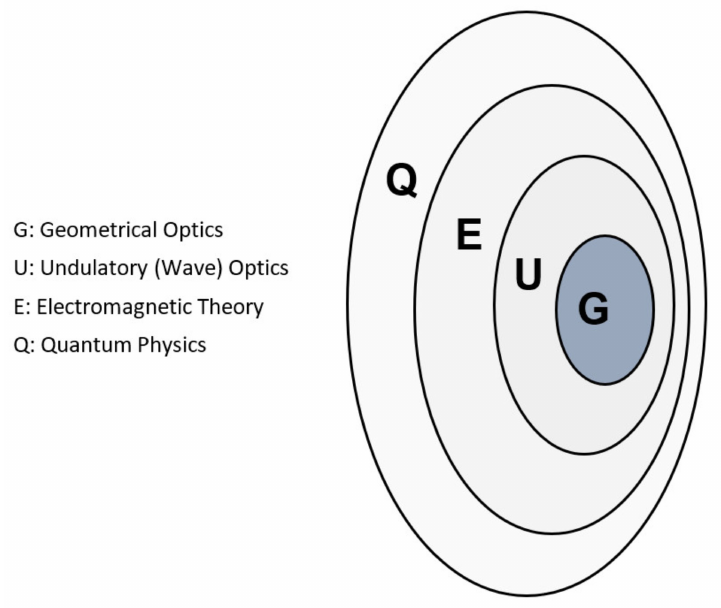
Figure 1. Different theoretical frameworks to treat light. Quantum mechanics is the most rigor- ous